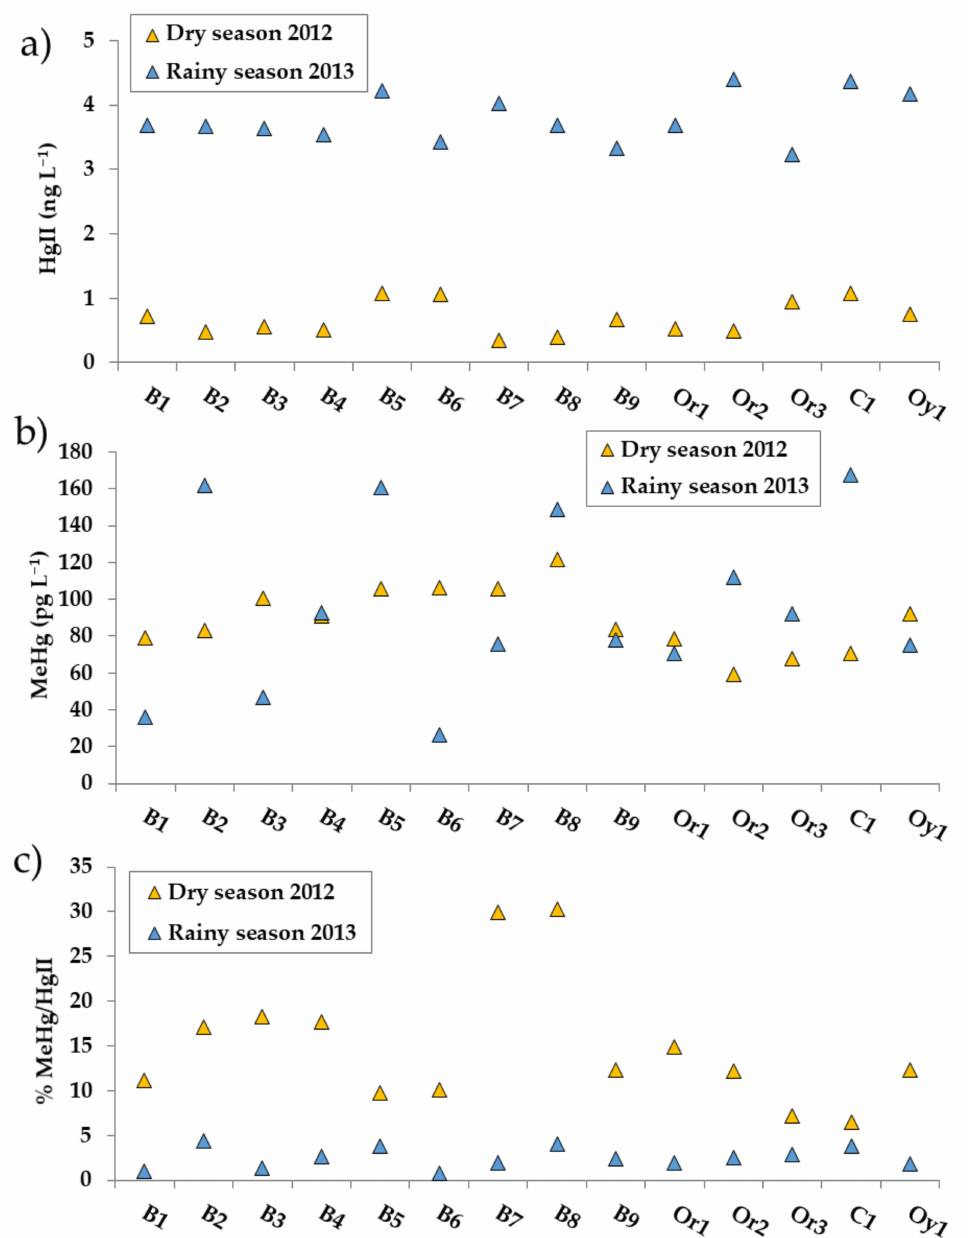
Figure 5. Dissolved Hg and monomethylmercury (MMHg) in water samples from the Oyack River catchment. ( a ): Total dissolved Hg (THg D) (ng L − 1 ), ( b ): MMHg (pg L − 1 ) and ( c ): %MMHg / THg D